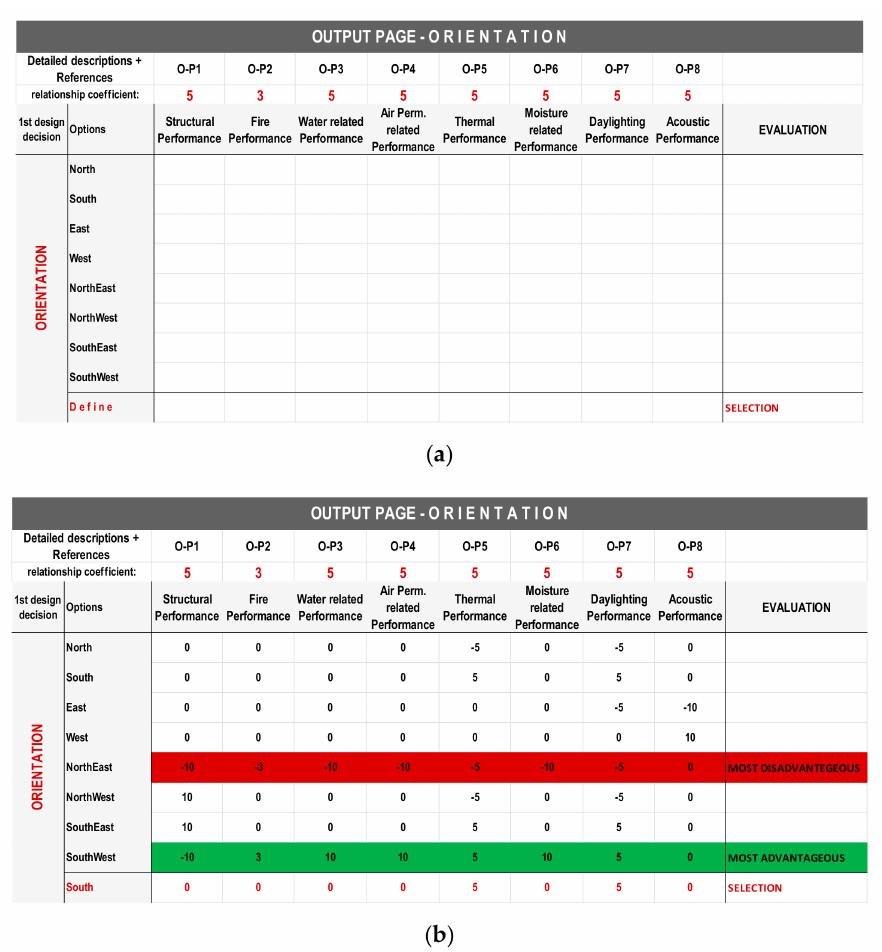
Figure 4. ( a ) Output and decision-making page for orientation; ( b ) Output and decision-making page for orientation (rated and